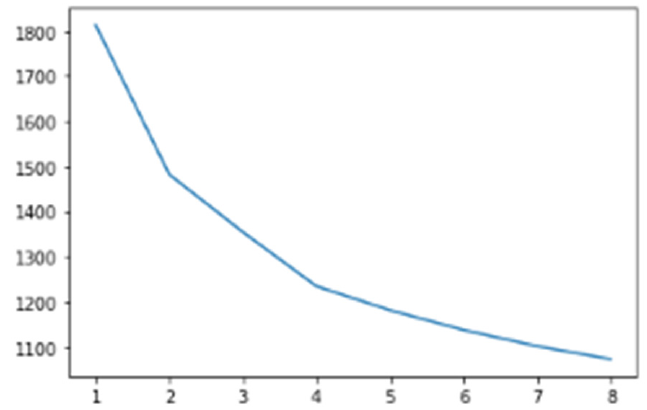
Figure 1. Curve Elbow to determine number of clusters.